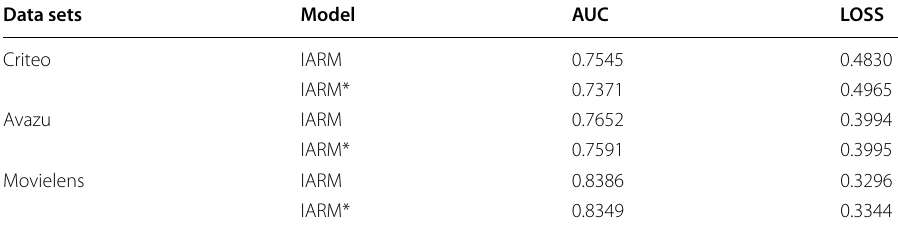
IARM is a full model, whereas IARM* is a model that eliminates user interest